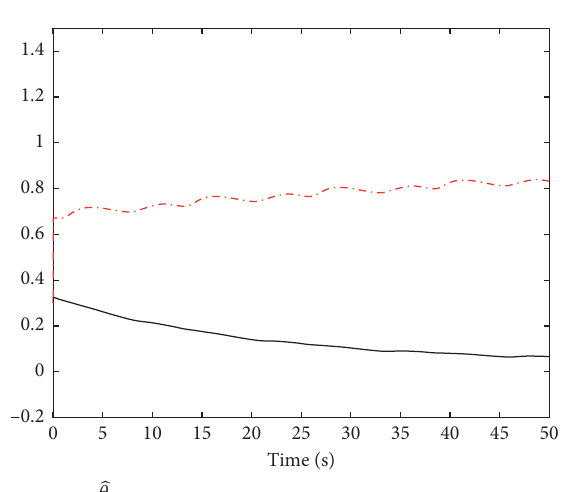
Figure 9: Actual control u .